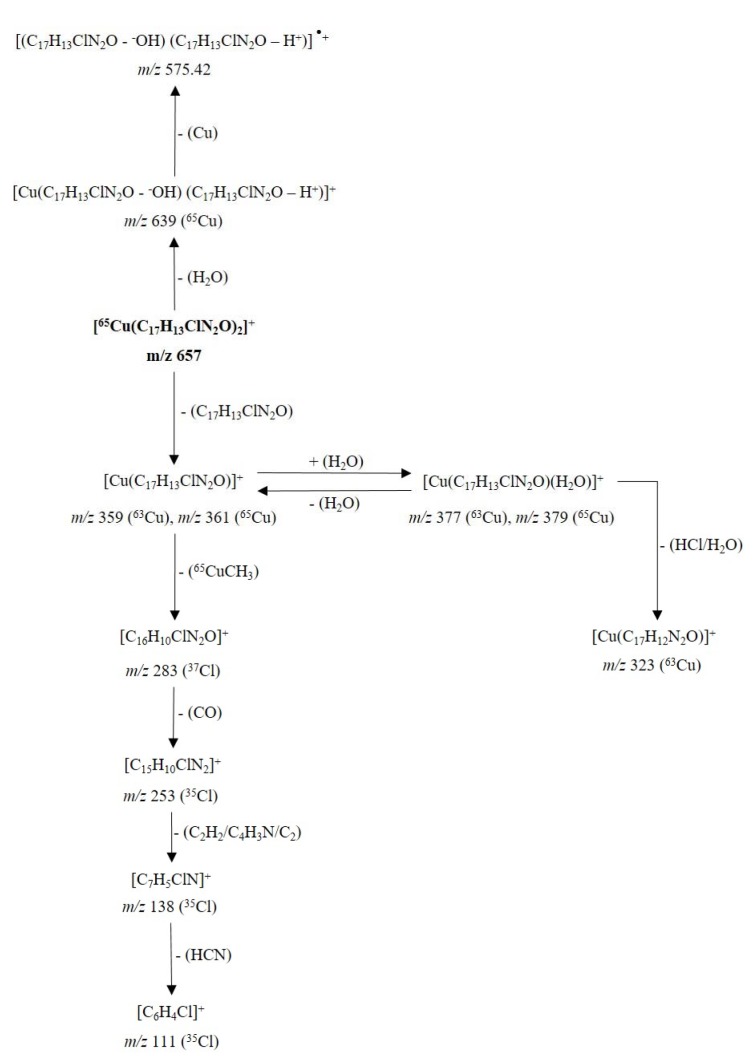
Proposed fragmentation for the ion [65Cu(C17H13ClN2O)2]+ at m/z 657 (cationic unit of 5a complex)